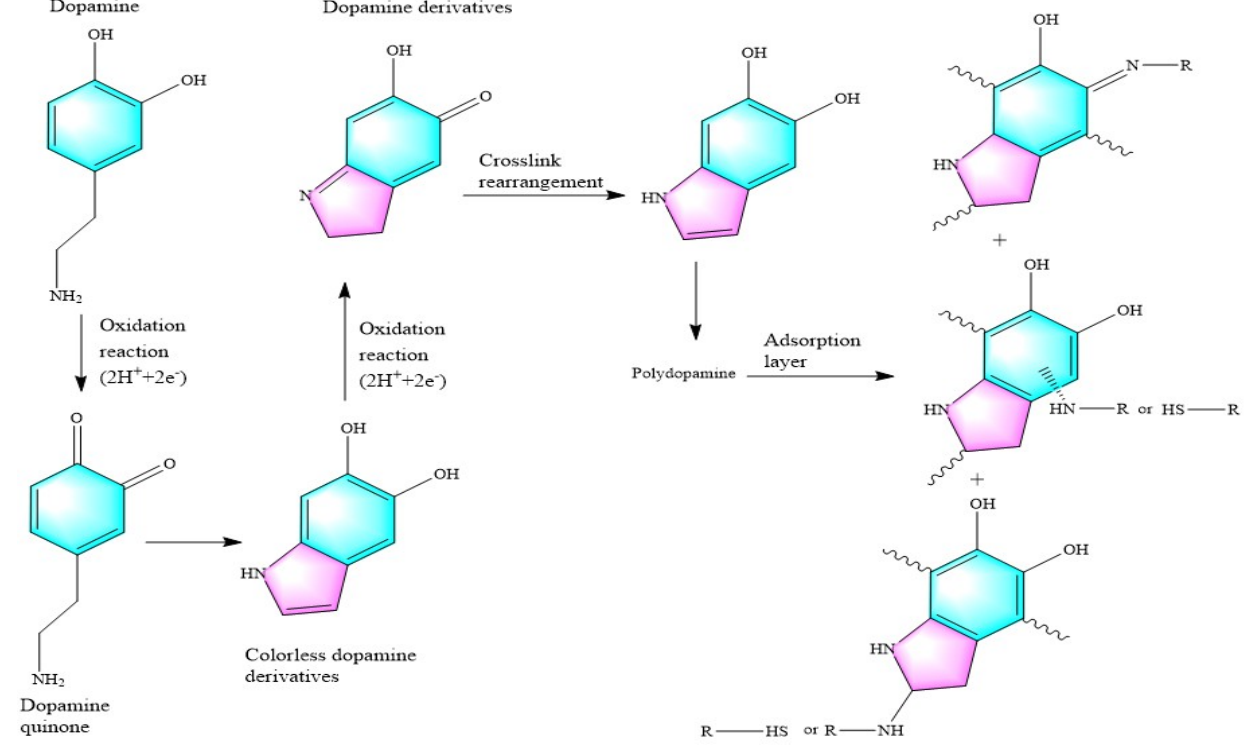
Figure 2. Schematic diagram of the oxidative polymerization mechanism of dopamine hydrochlo ‐ ride.